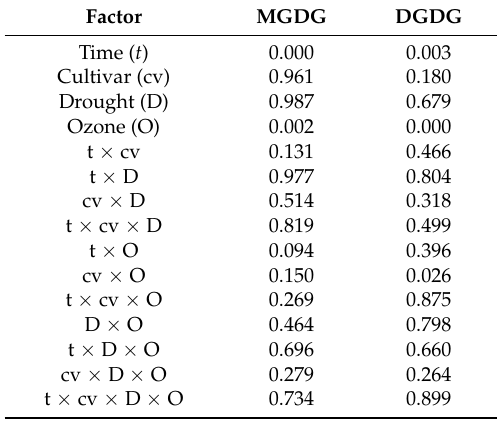
Table A3. Analysis of variance (ANOVA) of lipid contents. The displayed results are p -values for individual factors (time, cultivar, drought and ozone) and their multiple interactions. Values in bold are significant at α = 0.05. MGDG, monogalactosyl-diacylglycerol; DGDG,